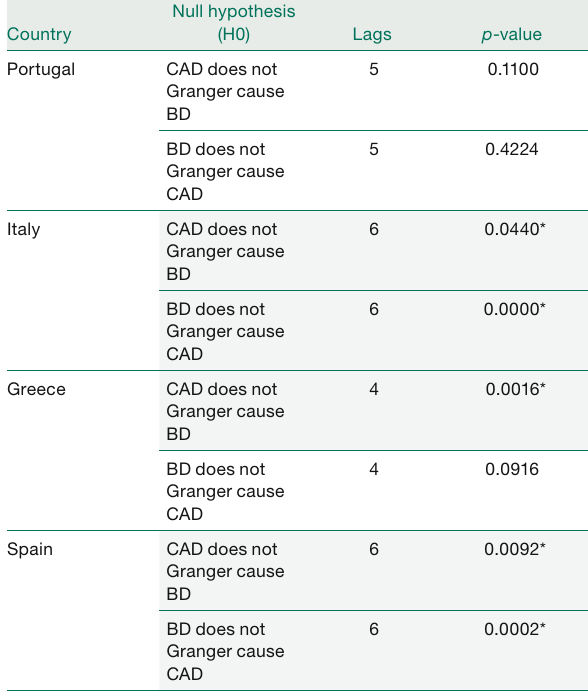
Granger causality test